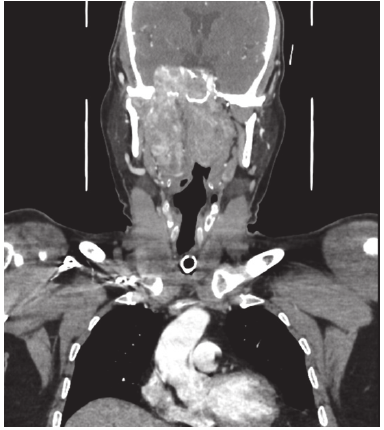
Figure 6: Coronal CT section (after contrast), showing an enhanc- ing mass occupying the nasal cavity, sphenoid sinus, and infratem- poral fossa and extending into the parapharyngeal space.